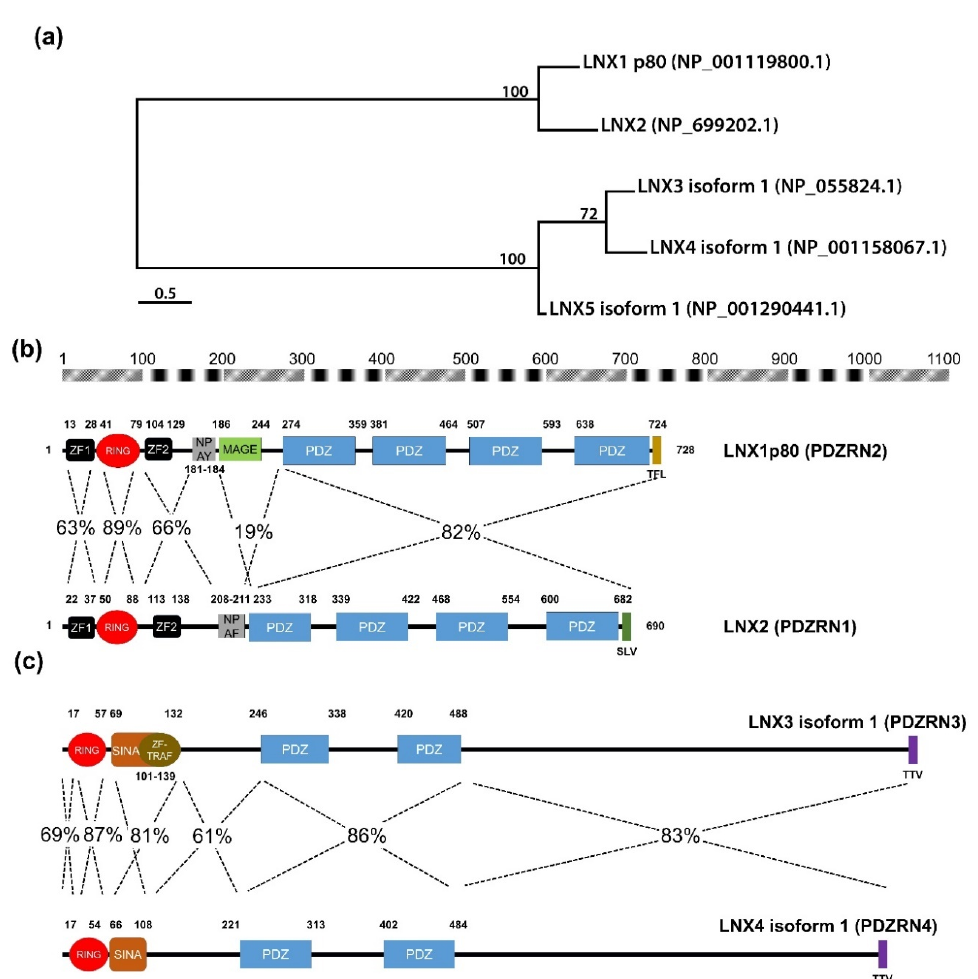
Figure 2. Amino acid sequence comparison of human LNXs ( a ) Phylogenetic tree of the LNX proteins. Maximum likelihood analysis was performed using to RAxML under the LG+GAMMA model. Analysis was carried out with five LNXs encoding the longest of their own variants (LNX1p80, LNX2, LNX3 isoform 1, LNX4 isoform 1, and LNX5 isoform 1). The numbers on each node represent bootstrap supported values. The scale bar indicates the number of substitutions / site. ( b , c ) Homology comparison of each domains was highlighted by the value of percentage. ( b ) Pairwise comparison between LNX1 and LNX2. The scale bar on the top indicates the approximate numbers of amino acids for the comparison of individual proteins. ( c ) Pairwise comparison between LNX3 (PDZRN3) and LNX4 (PDZRN4).